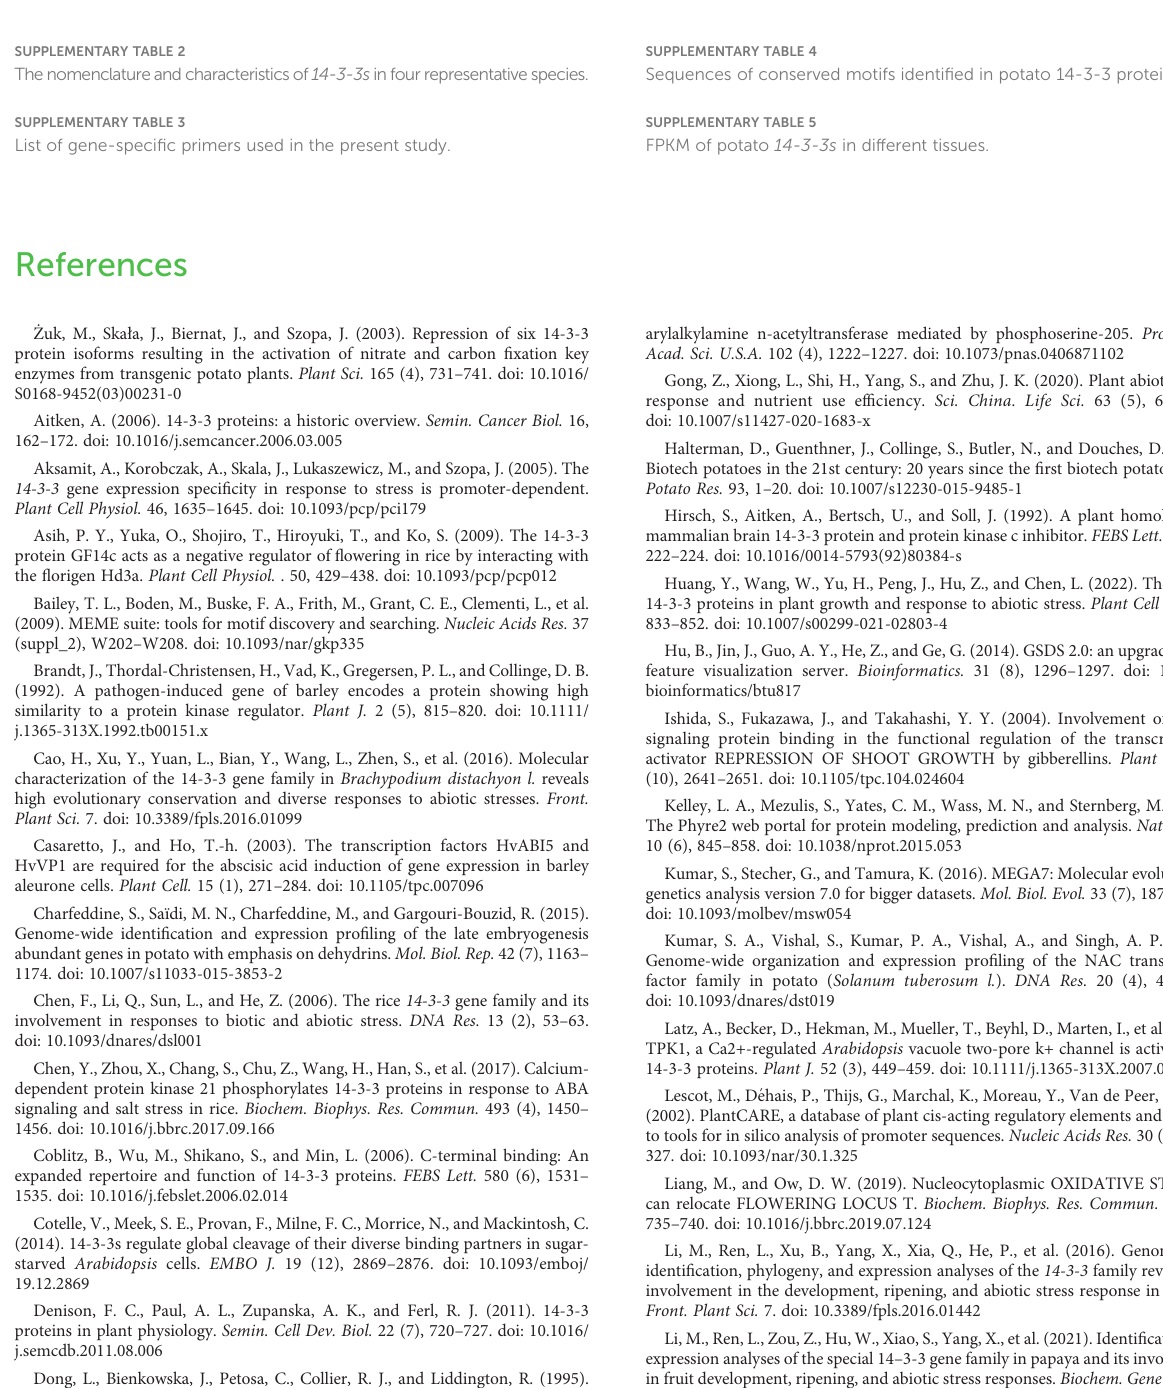
SUPPLEMENTARY TABLE 4 Sequences of conserved motifs identi fi ed in potato 14-3-3